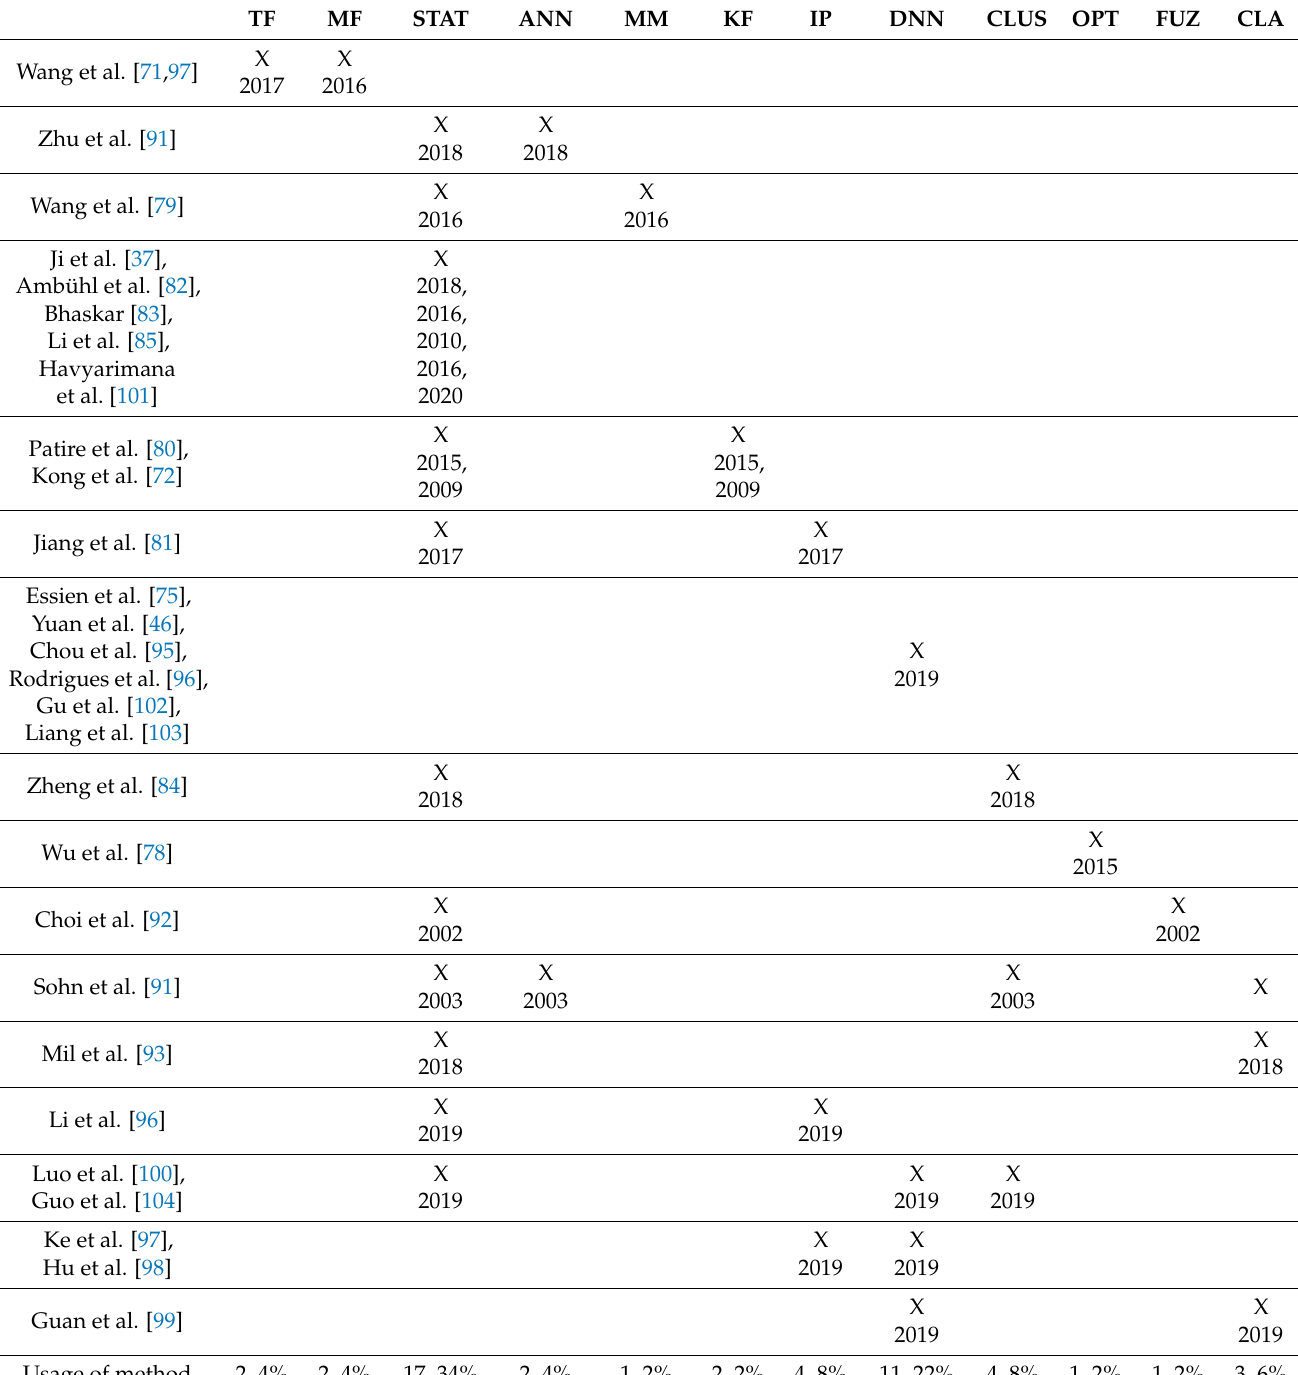
Table 5. Representation of Methods for Data Fusion (DF) (MF, TF–Matrix and Tensor Factorization;